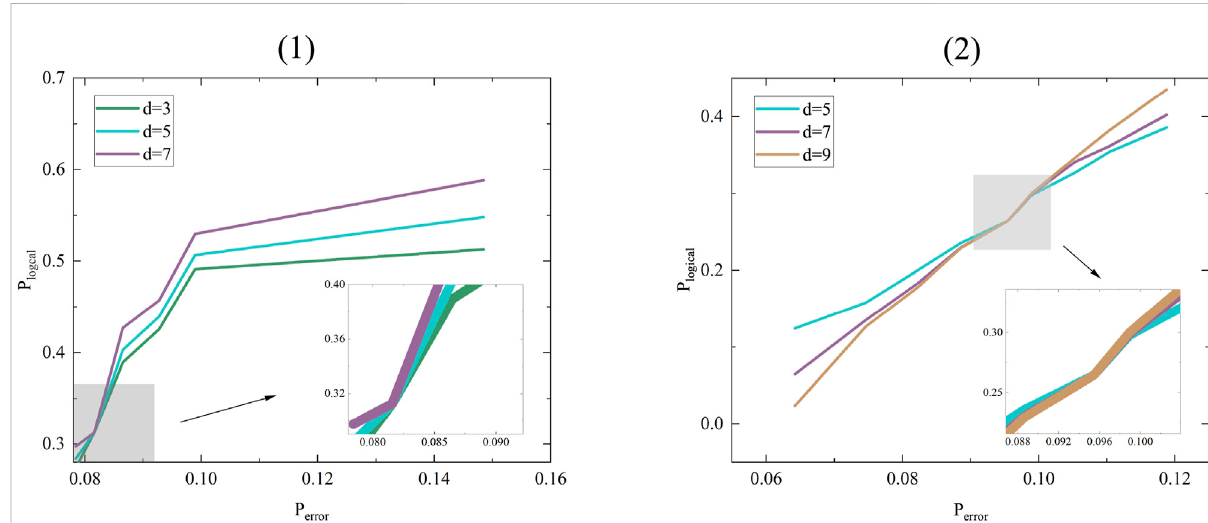
FIGURE 5 (1)Function correspondence of physical error rate p error , logical error rate p logical , and code distance d = 3, 5, 7. Threshold p threshold = 0.081574. (2)Function correspondence of physical error rate p error , logical error rate p logical , and code distance d = 5, 7, 9. Threshold p threshold = 0.09542. The abscissa represents thephysicalerror rate, theordinaterepresents the logical error rate. For better numerical analysis, thedifferent codedistances d are marked in different colours, d = 3 in green, d = 5 in blue, d = 7 in purple and d = 9 in brown.